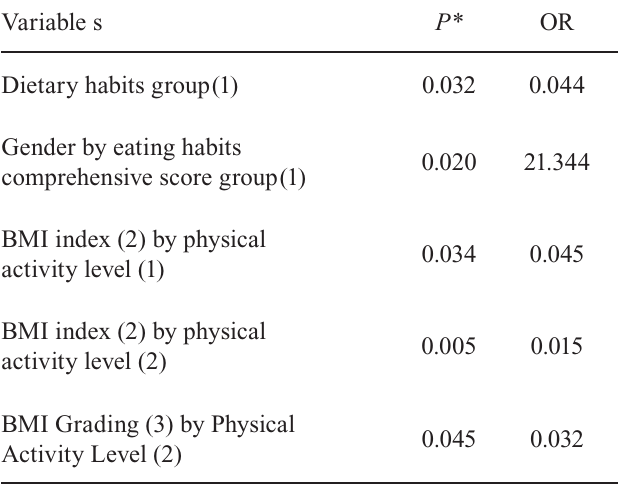
TABLE IV - Multiple logistic regression analysis of